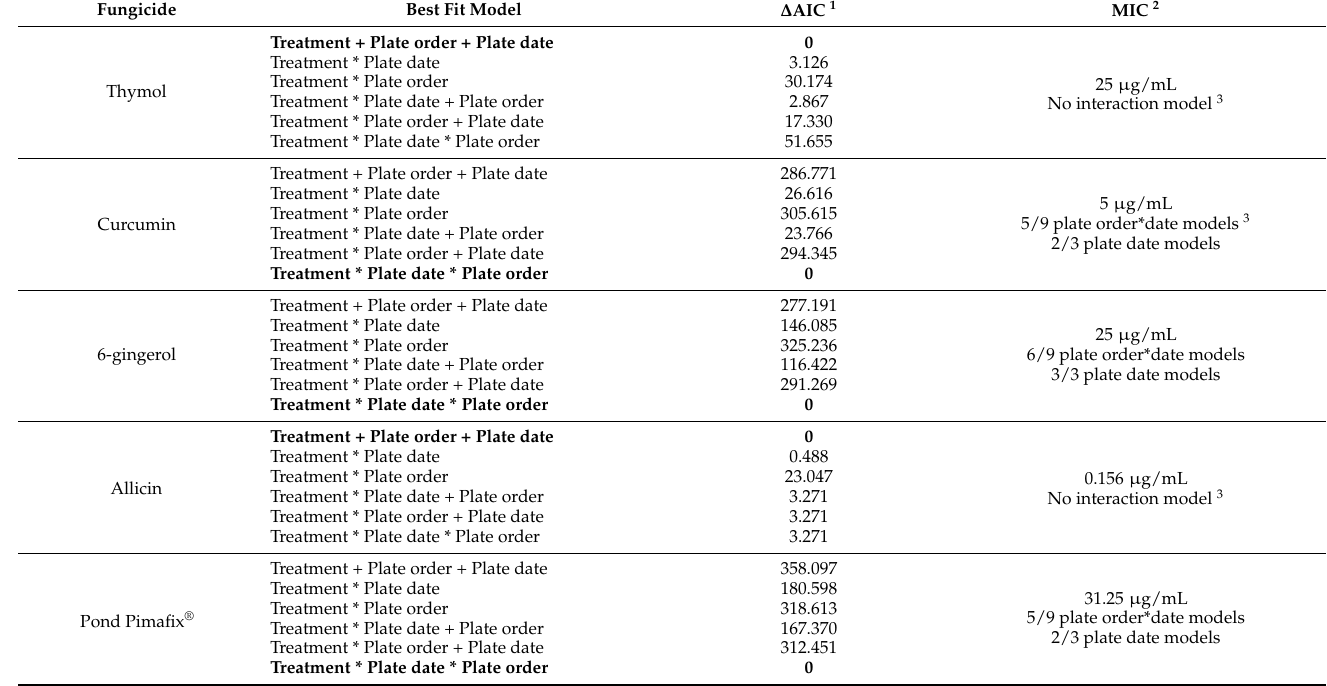
Table 2. Six generalized least-squares (GLS) models per fungicide testing for two-way or three-way interactions between treatment (i.e., six levels of concentrations tested), plate date (i.e., three separate days that the three trials were completed), and plate order (i.e., three groupings of the first, second, and third plates completed across all three